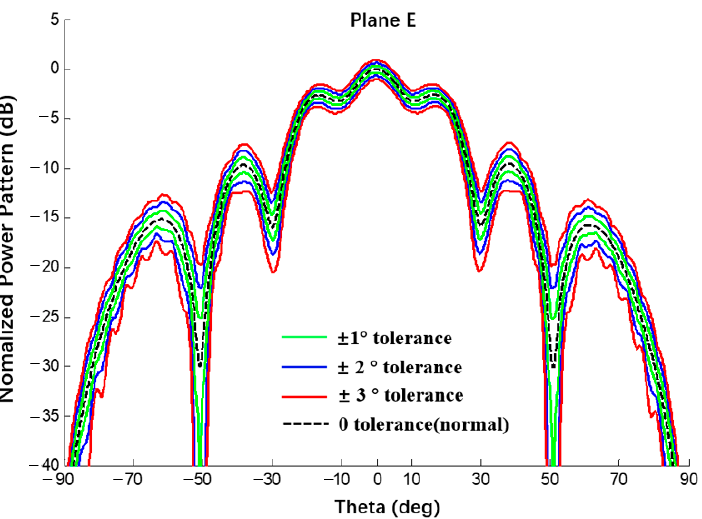
Figure 21. Interval power pattern of excitation phase error of spherical CAAs (Plane E, uniform excitation).